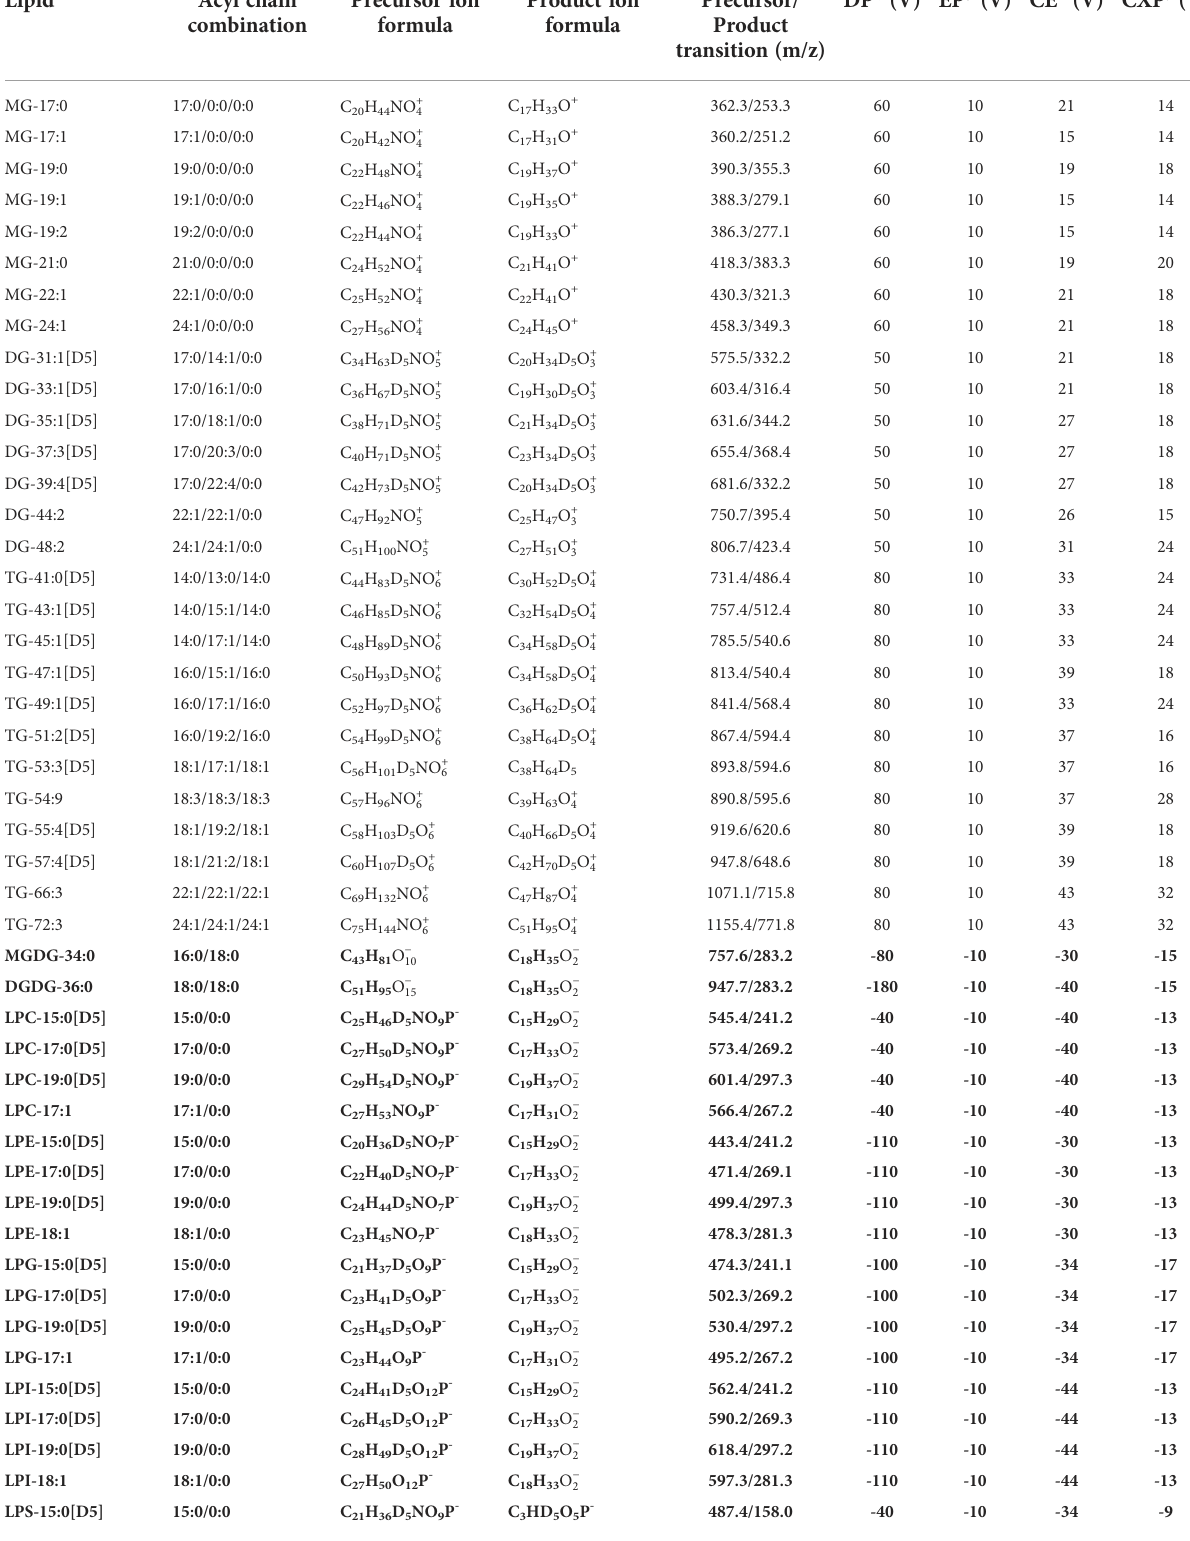
TABLE 1 Lipid-dependent MS parameters for MRM scan survey. Lipid Acyl chain